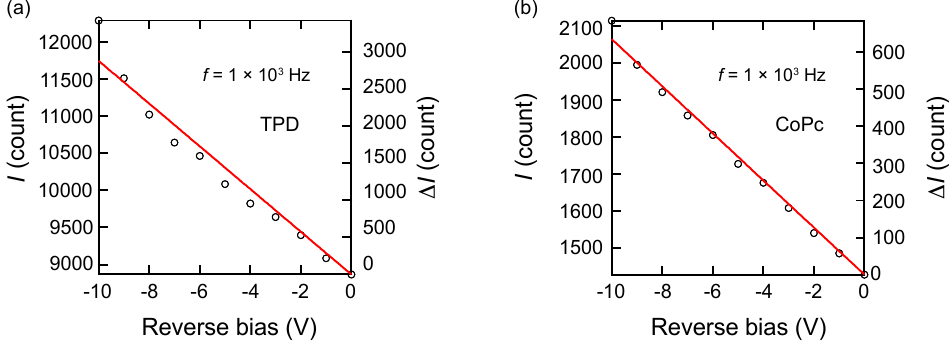
Figure 3. I (left axis) and ∆ I (right axis) versus applied reverse-bias voltage alternated with forward 10 V with 1 × 10 3 Hz for the ITO/TPD/Alq 3 /Al device ( a ) and ITO/CoPc/Alq 3 /Al device ( b ). The solid line is ∆ I calculated using Equation (6) (see main text).